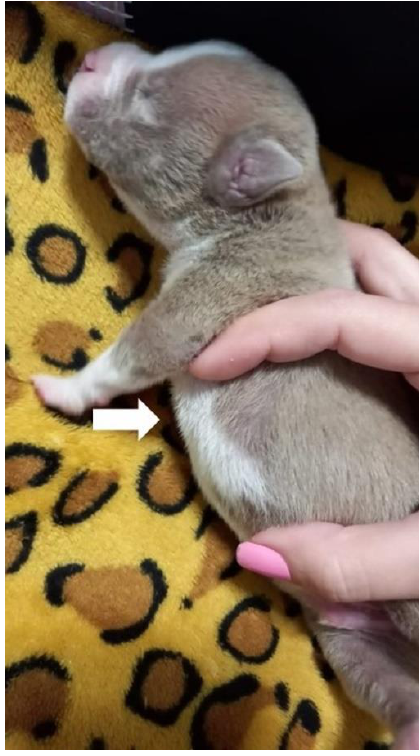
Figure 13. Patient after splint removal. Thorax presenting absence of ventrodorsal narrowing in the sternal region (arrow) after noninvasive treatment.